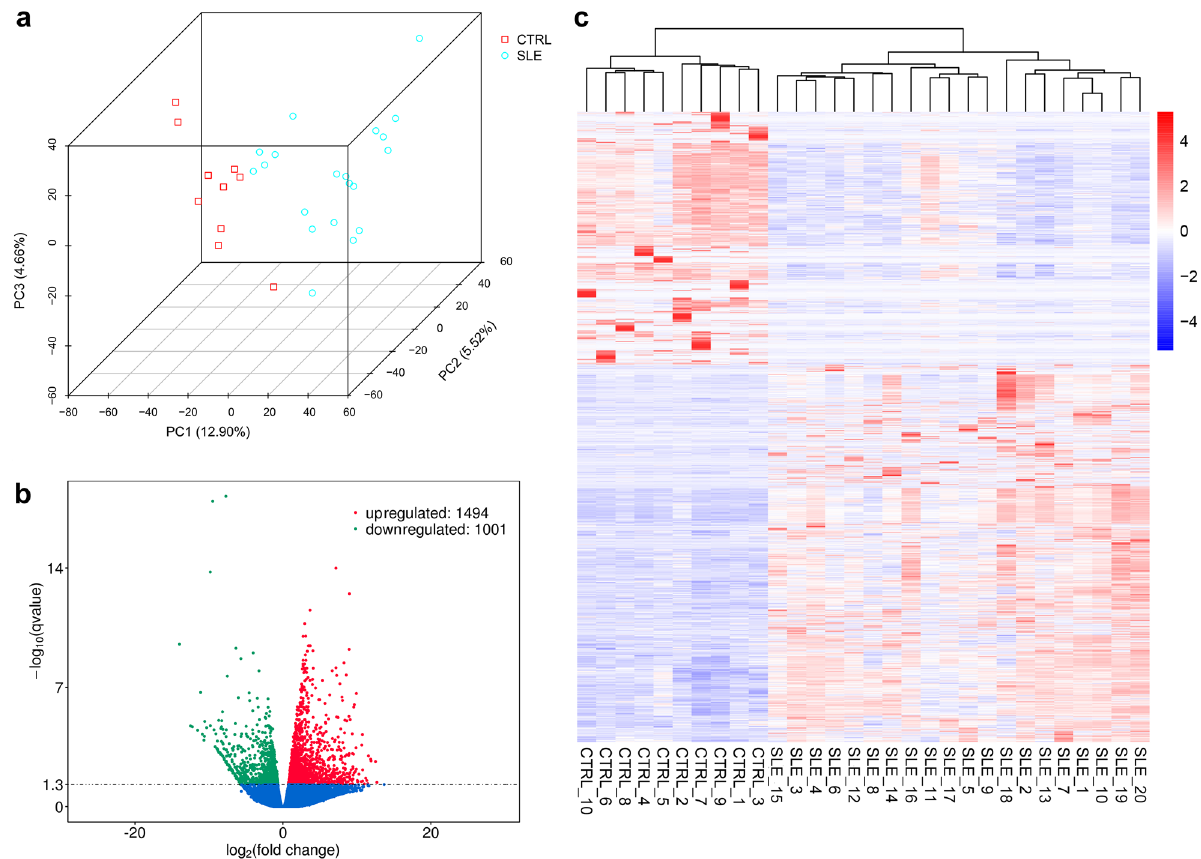
Figure 1. Sequencing samples and differentially expressed genes. (a) Principal component analysis (PCA) plot of the sequencing samples. 3D PCA is conducted to evaluate the clustering natures and repeatability of the samples. Percentages are the contribution ratios. (b) Volcano plot of the genes differentially expressed between SLE group and CTRL group. Each point represents one gene that is detectable in both groups. (c) The cluster of 2495 genes differentially expressed between the SLE group and the CTRL group. Corrected- P <